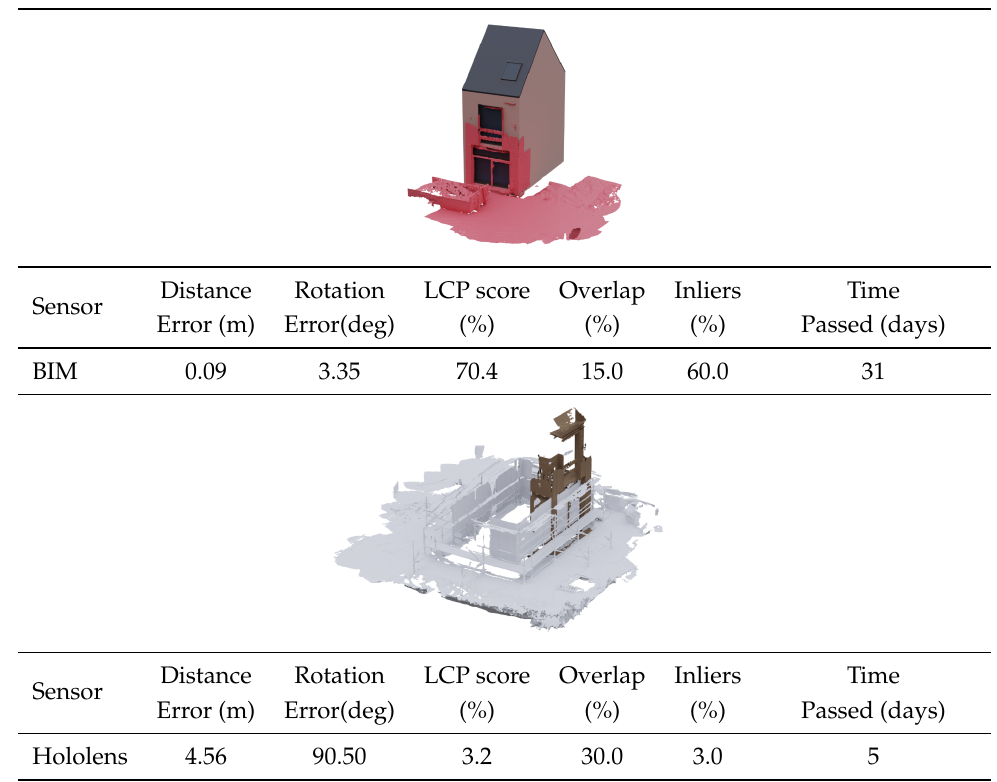
Table 8. Three-dimensional matching estimations based on Super 4 PCS